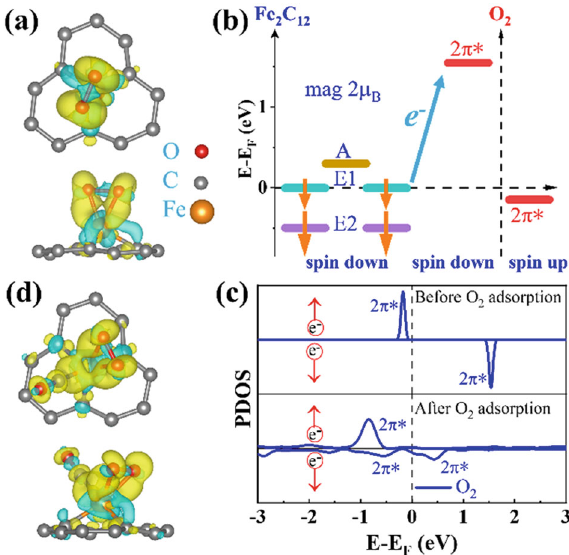
Fig. 5 Intrinsic reactivity of 2D-Fe 2 C 12 . a Charge differential density plots upon O 2 adsorption on 2D-Fe 2 C 12 , respectively, with the yellow (cyan) isosurface representing charge accumulation (depletion). b Schematic showing the magnetism-induced catalytic activity of 2D-Fe 2 C 12 , transferring the electron in the partially fi lled Fe E1 band in the spin-down channel to O 2 . c The PDOS of O 2 before and after adsorption. d Charge redistribution induced by CO and O 2 co-adsorption on 2D-Fe 2 C 12 .